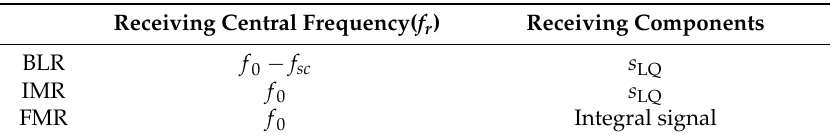
Figure 2. The correlation output SNIR loss of ACE-BOC(15,10,[1,3,1,3]) , where the central frequency of receiving of Matched receiving and IMR is at f 0 , and the central frequency of BLR is at f 0 – f sc . The IMR and BLR receives the component s LQ , whose power ratio among the useful transmitting power is 3/8. Table 1. Receiver configuration of the three receiving strategies of ACE-BOC, which is used in the evaluation in Section 6.2.